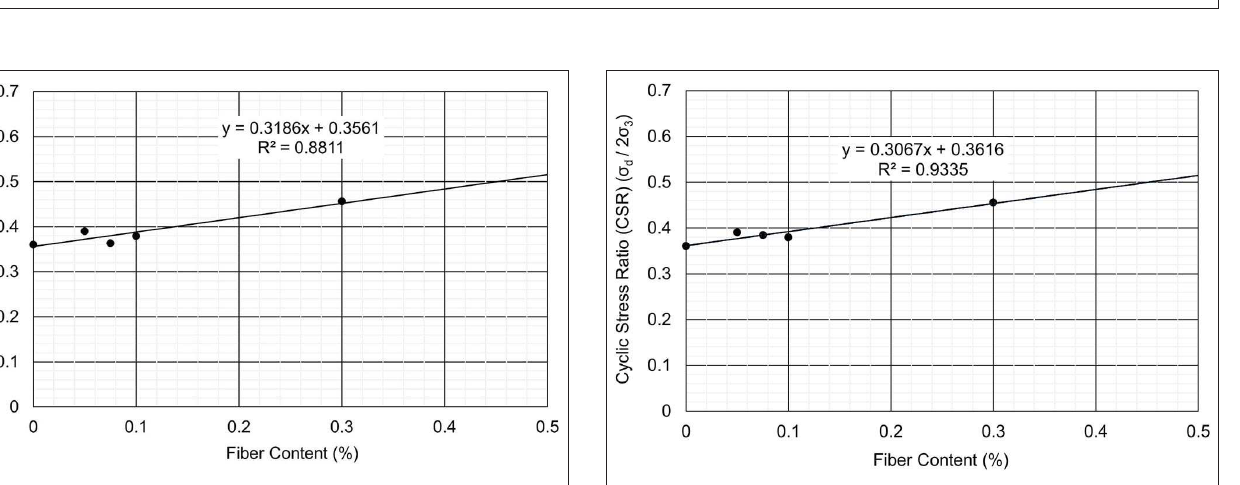
FIGURE 5 | Variation of liquefaction resistance (2.5% DA deformation at N = 10) of sand with fiber contents at effective confining pressures of 34.48